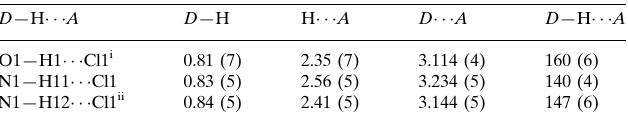
Hydrogen-bond geometry (A˚ , (cid:3)